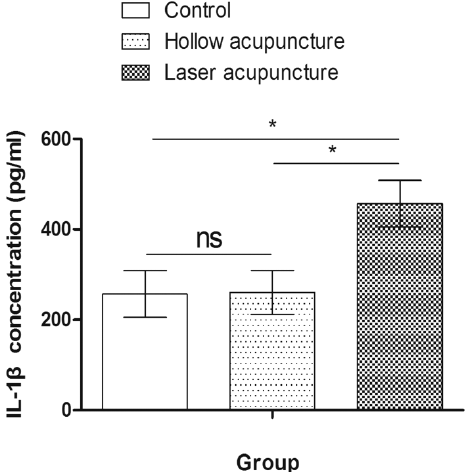
Fig. 7. IL-1 (cid:1) expression in serum. The level of IL-1 (cid:1) in serum were detected. The values presented are mean (cid:2) S.E.M. Data were analyzed using ANOVA and multiple comparison. There was no signi¯cant di®erence between Control group and Hollow group ( p ¼ 0 : 960 > 0 : 05). There was signi¯cant di®erence be- tween Control group and Laser group ( p ¼ 0 : 033 < 0 : 05), and between Hollow group and Laser group ( p ¼ 0 : 032 < 0 : 05). * P < 0 : 05; ns: P > 0 : 05.